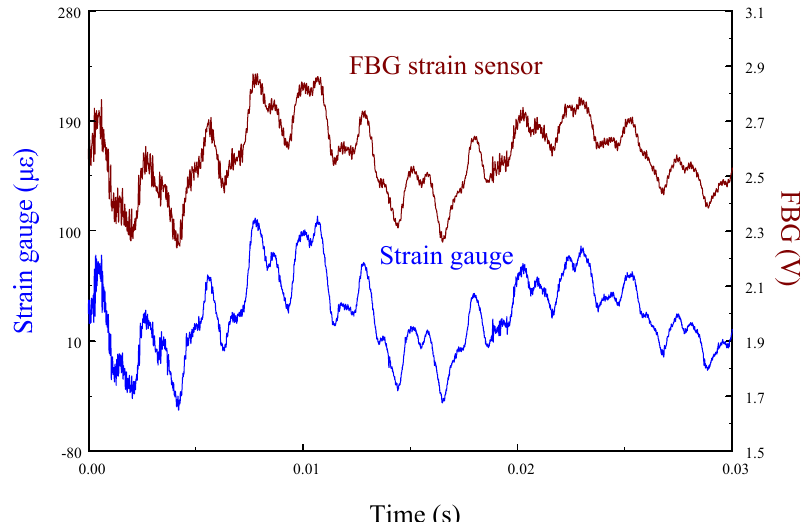
Figure 8. Transient strain responses of the smart cantilever beam subjected to the impact loading by a steel ball within 0.03